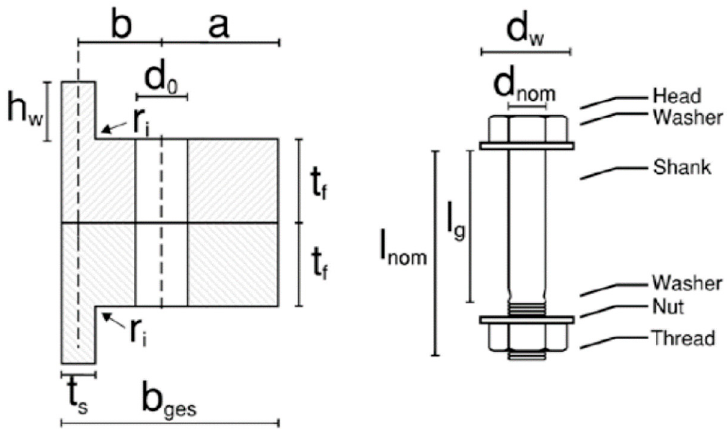
Figure 2. Schematic illustration of flange dimensions. Table 2. Flange dimensions employed in finite element model (FE) simulations—all dimensions in mm.